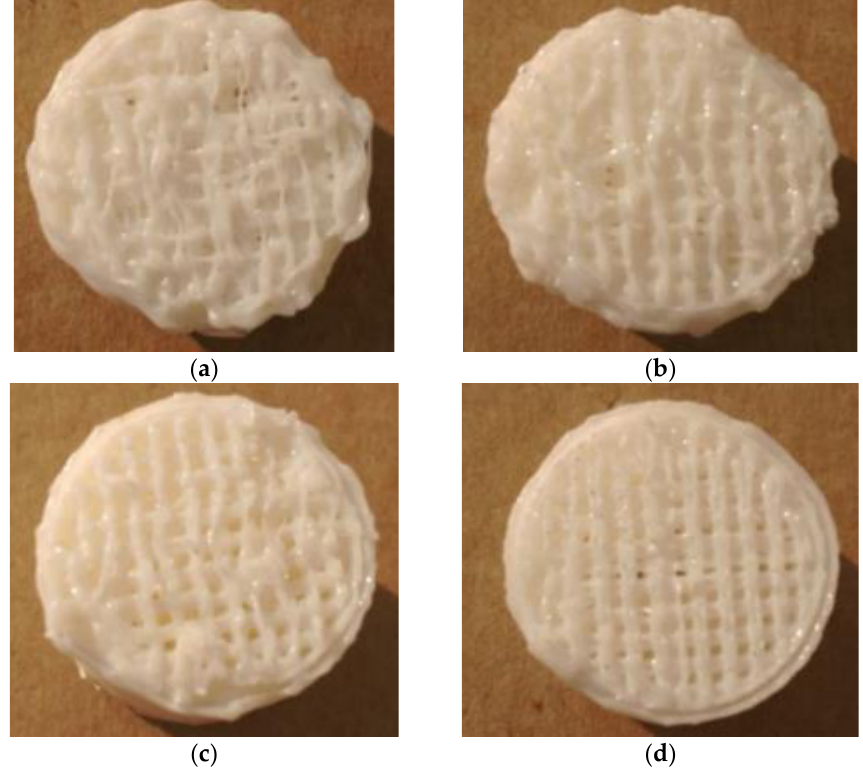
Figure 7. Images of the bottoms of the linear support experimental parts removed under different linear support densities: ( a ) 30% linear support density (bottom view); ( b ) 50% linear support density (bottom view); ( c ) 70% linear support density (bottom view); ( d ) 90% linear support density (bottom view).